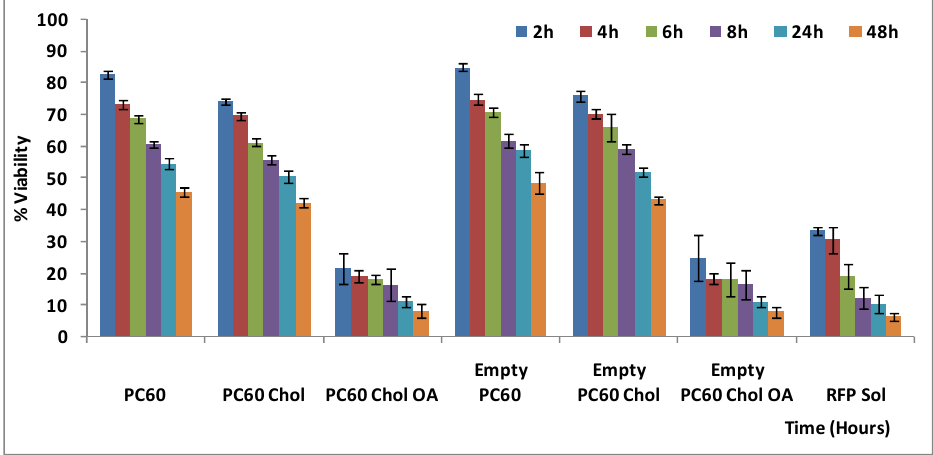
Figure 4. In vitro cytotoxic effect of empty and RFP-loaded liposomes compared with RFP solution on A549 cells at different incubation